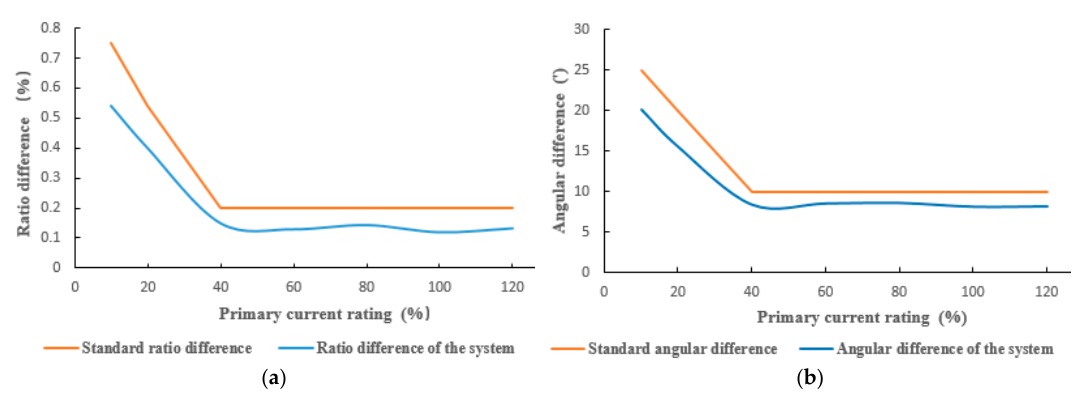
Figure 10. ( a ) Ratio difference of the system and standard ration difference; ( b ) Angular difference of the system and standard angular difference.